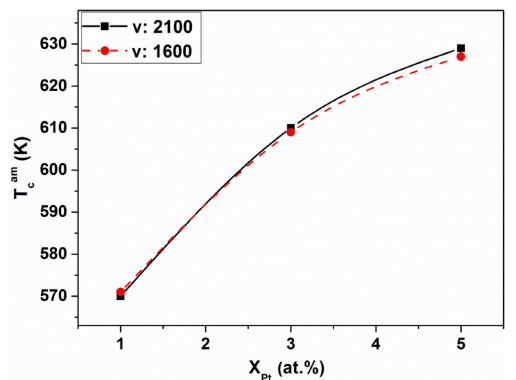
Figure 10. Curie temperature T Cam for Fe 85-x -Pt x B 15 glassy alloys versus Pt-content. Adopted from [65], with permission from the Institute of Physics of the Polish Academy of Sciences,